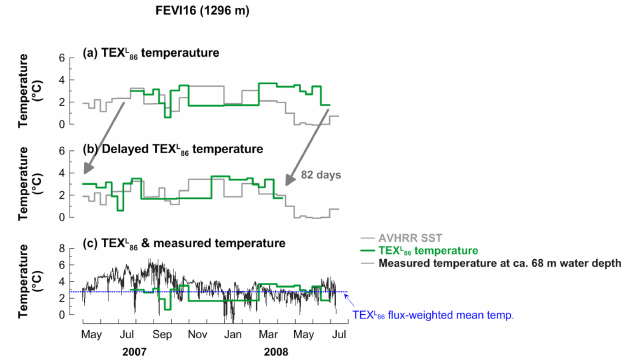
Figure 7. Changes in TEX L derived SSTs (a) , time-delayed TEX L sensor-measured temperatures (c) at approximately 68m water depth at site